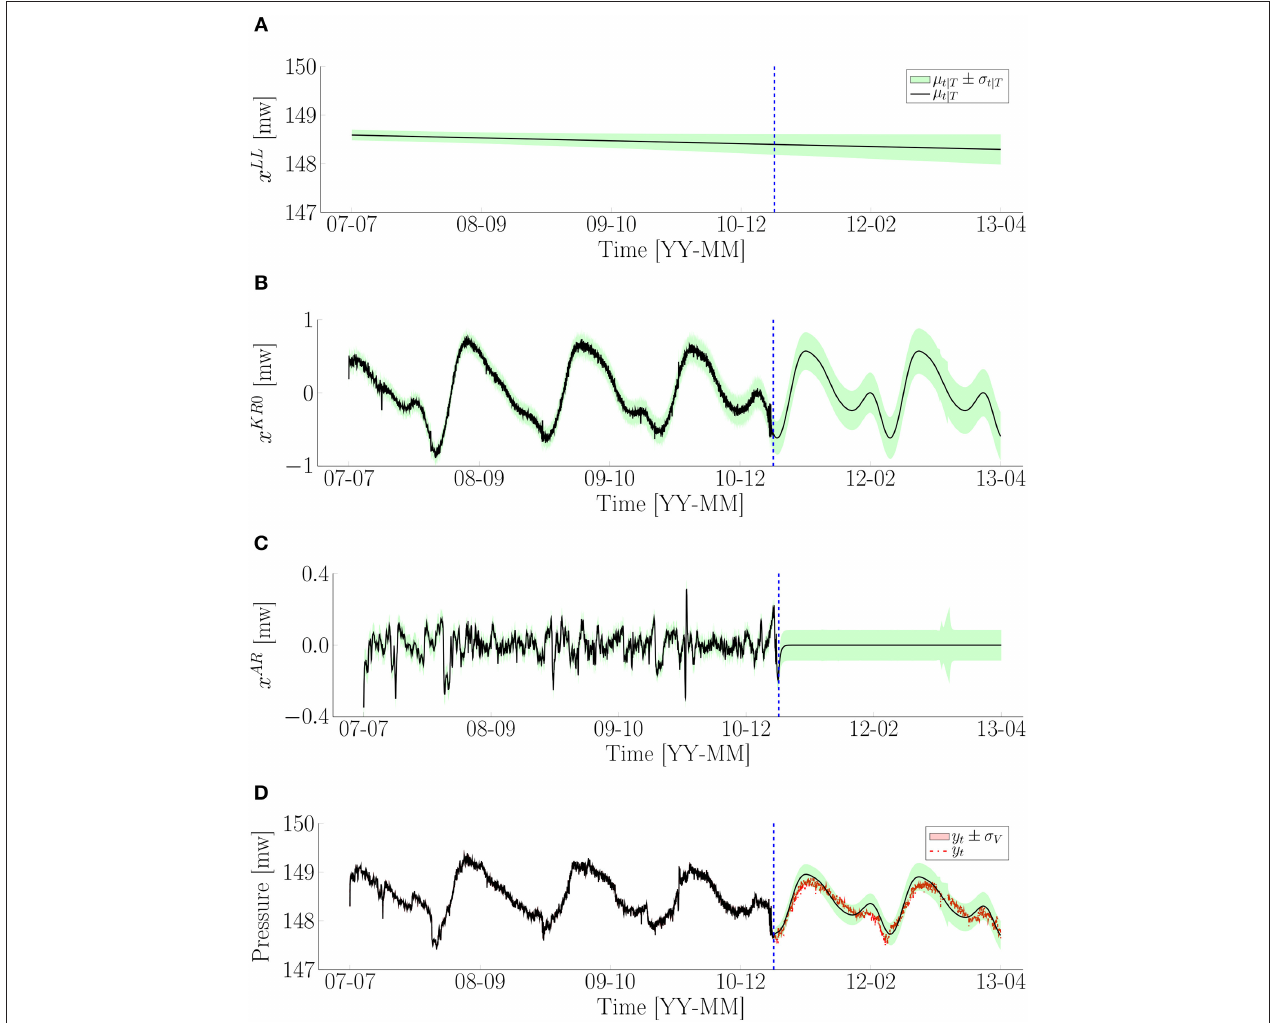
FIGURE 10 | Illustration of the estimation of hidden state variables for the piezometric pressure data: (A) Baseline component, x B t ; (B) Hidden predicted pattern, x KR t ,0 ; (C) Autoregressive component, x AR t ; (D)